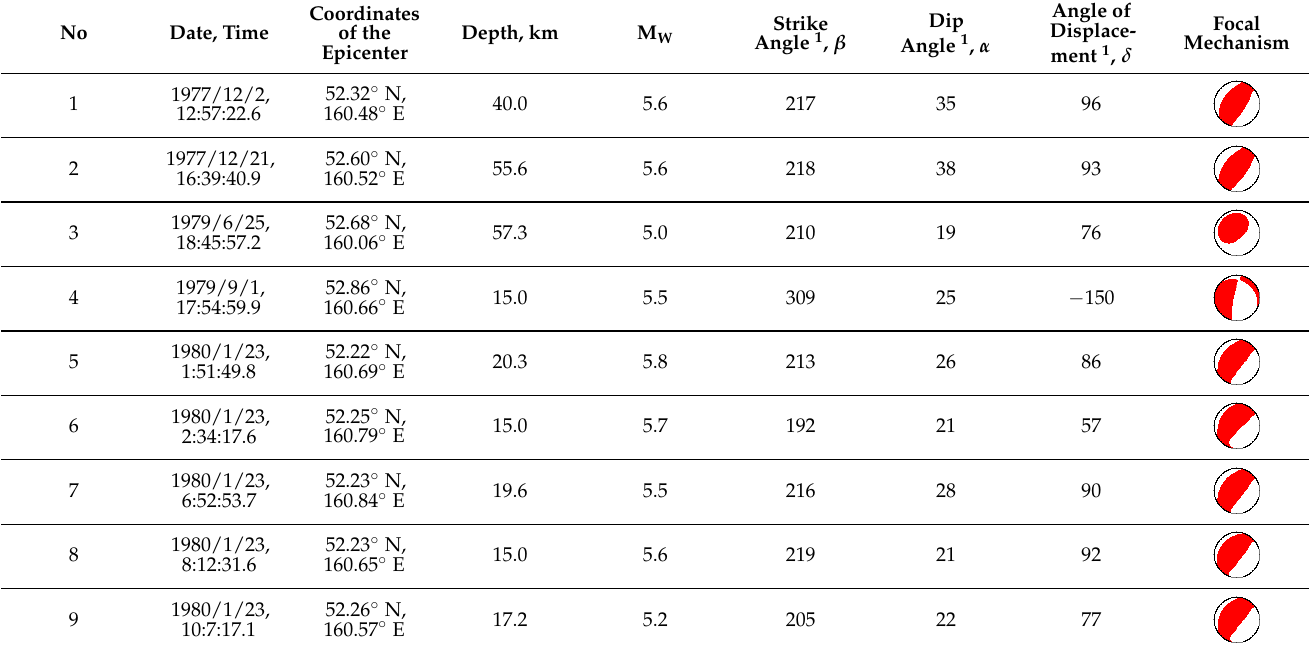
Table 1. Data on nine small-focus earthquakes that occurred during the period from 1 January 1976 to 30 June 2022 in the area under the study (latitude interval: [52 ◦ , 53 ◦ ], longitude interval: [160 ◦ , 161 ◦ ]).